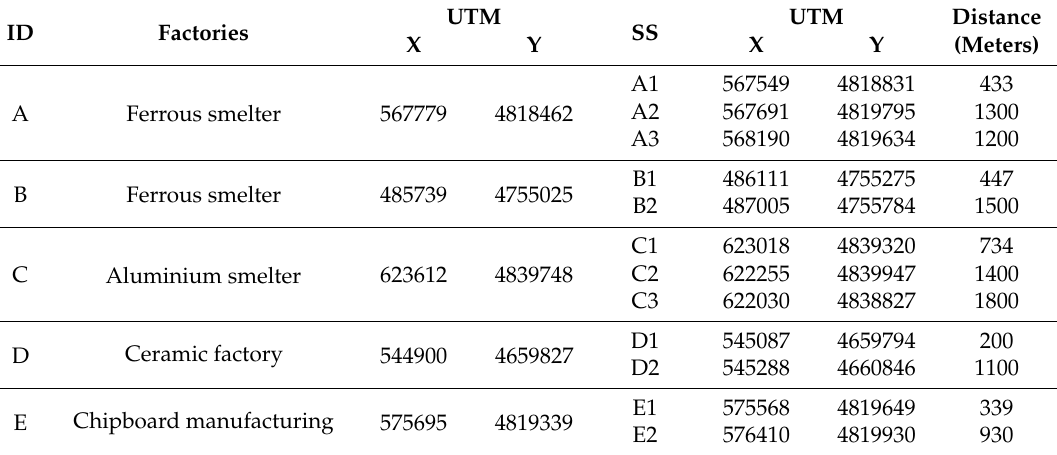
Table 1. Description of sampling sites (SS): coordinates and distance from the